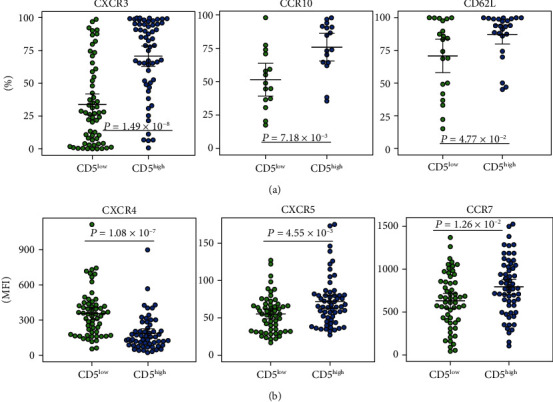
Distribution of (a) percentages of positive cells for CXCR3, CCR10, and CD62L and (b) expression (MFI) of CXCR4, CXCR5, and CCR7 on CD5high and CD5low subpopulations in patients with CLL. Group means are indicated by horizontal bars, error bars indicate 95% CI.